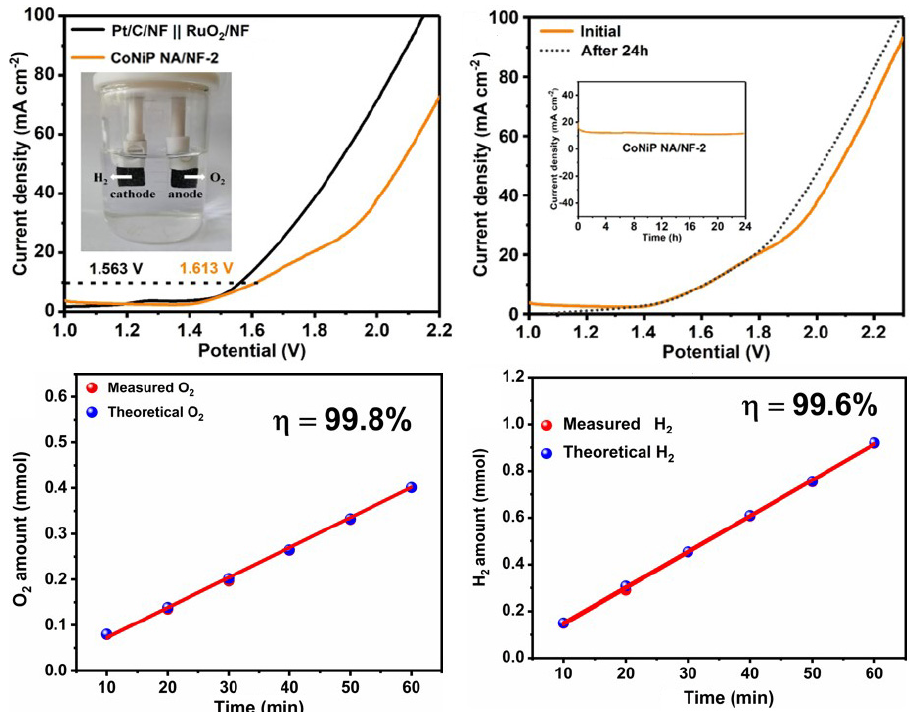
Figure 7. ( a ) LSV polarization curves of CoNiP NA/NF-2 for overall water splitting. ( b ) Chronopotentiometry test of CoNiP NA/NF-2 at a current density of 10 mA cm − 2 in a two-electrode electrolyzer for 24 h. The faradaic efficiency of ( c ) O 2 generation over CoNiP NA/NF-2 electrode at 10 mA cm − 2 and ( d ) H 2 generation over CoNiP NA/NF-2 electrode at 10 mA cm − 2 for 1 h.